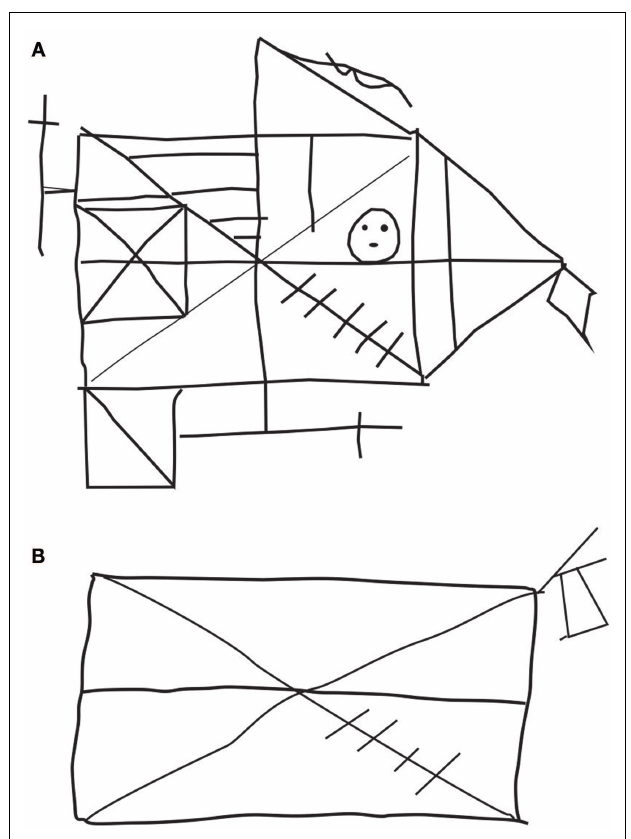
FIGURE 2 | Copying (A) and reproduction by heart after half an hour (B) of the Rey–Osterrieth figure .